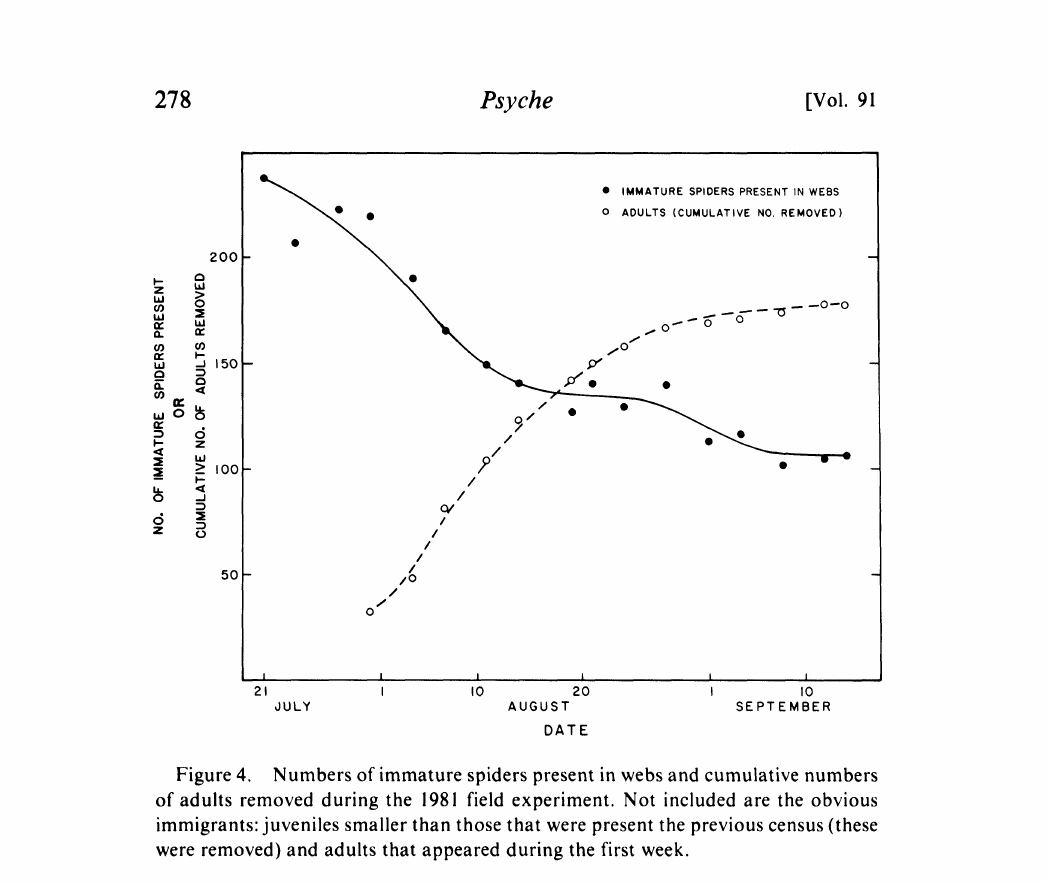
Figure 4. Numbers of immature spiders present in webs and cumulative numbers of adults removed during the 1981 field experiment. Not included are the obvious immigrants: juveniles smaller than those that were present the previous census (these were removed) and adults that appeared during the first